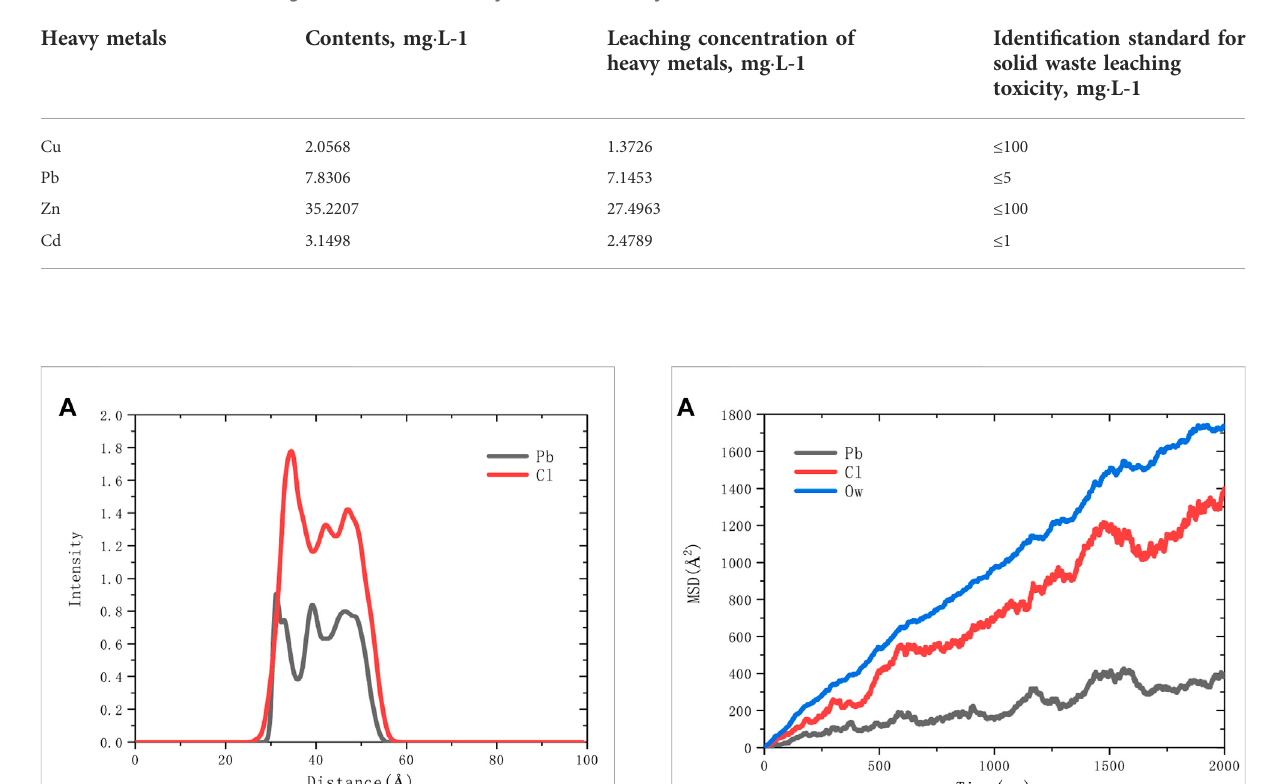
TABLE 1 Contents and leaching concentrations of heavy metals in MSWI fl y ash.